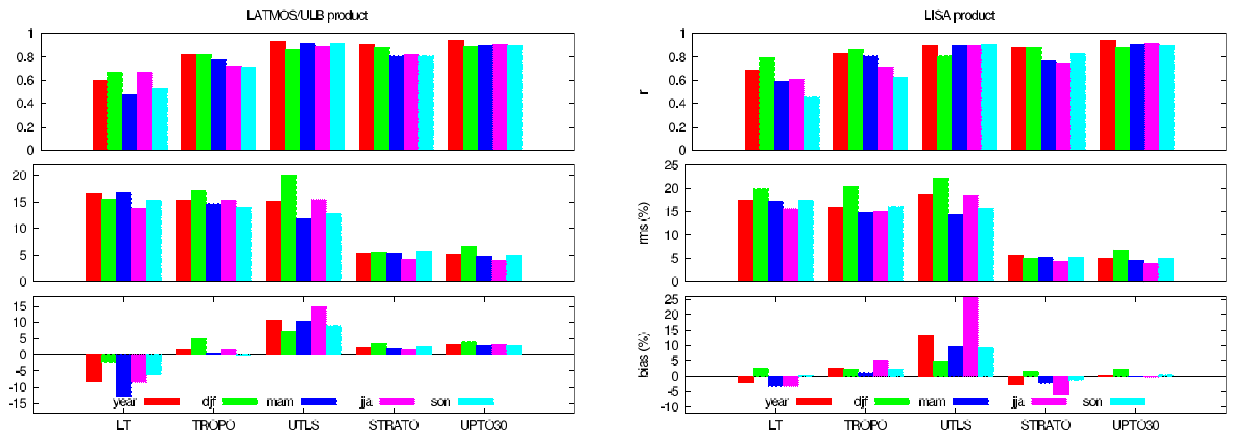
Fig. 11. Same as Fig. 10 for the LATMOS/ULB product. Fig. 12. Same as Fig. 10 for the LISA